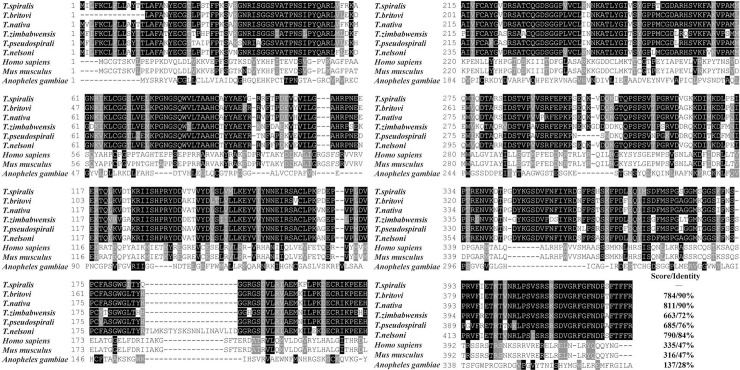
Sequence alignment of serine protease from Trichinella spiralis (ABY60762) with other species of the genus Trichinella and other organisms.The serine proteases was from Trichinella spp.: T. britovi (KRY59723.1), T. nativa (KRZ48330.1), T. zimbabwensis (KRZ02345.1), T. pseudospirali (KRY01512.1), T. nelsoni (KRX27556.1), Homo sapiens (CAB91984.1), Mus musculus (EDL11329.1), Anopheles gambiae (CAB90819.1). The multiple sequences alignment was performed in the Clustal X and displayed using BOXSHADE. Black shade indicated that residues identical to TsSP, and conservative substitutions were shaded grey. The numbers at the end of each sequence represent the score and percent identity to TsSP.